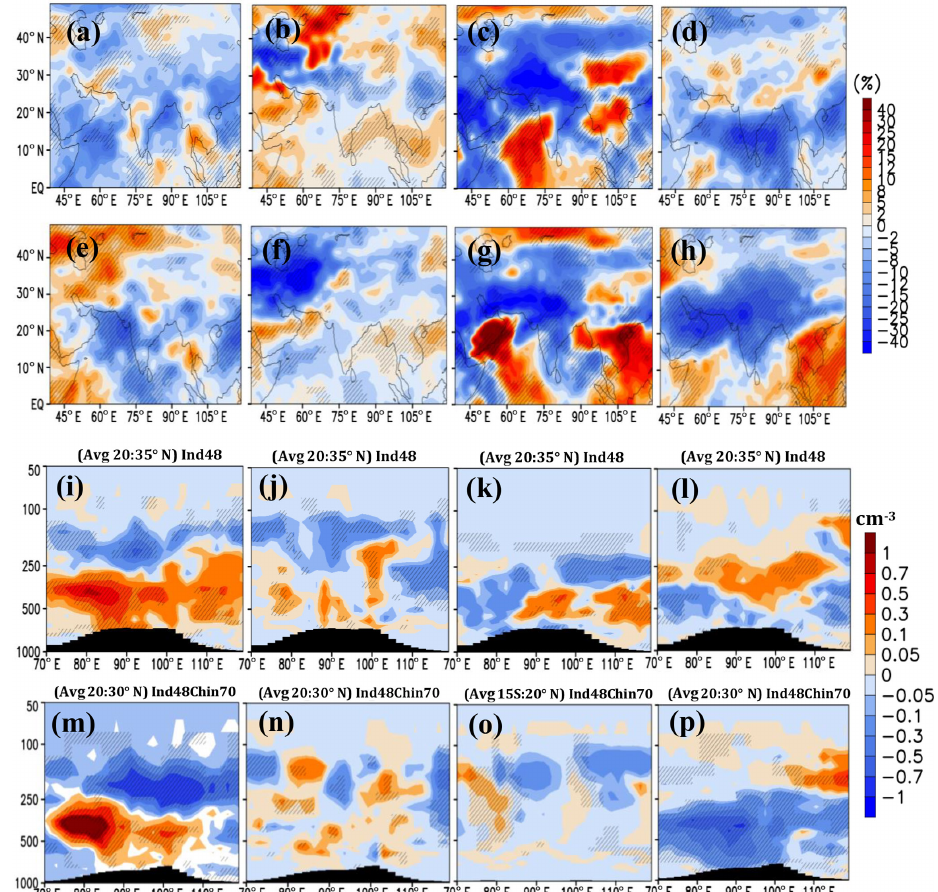
Figure 10. Seasonal distribution of anomalies in cirrus cloud (%) from Ind48-CRTL simulations for the (a) pre-monsoon, (b) summer- monsoon, (c) post-monsoon and (d) winter seasons; (e) – h) same as (a) – (d) but for Ind48Chin70-CTRL simulations. Seasonal distribution of anomalies in ice crystal number concentration (ICNC; cm − 3 ) from Ind48-CTRL for the (i) pre-monsoon, (j) summer-monsoon, (k) post- monsoon and (l) winter seasons; (m) – (p) same as (i) – (l) but from Ind48Chin70-CTRL simulations. For the vertical cross section, averages obtained over latitudes or longitudes are indicated in each panel. The black hatched lines indicate the 99% significance level. The black vertical bars indicate